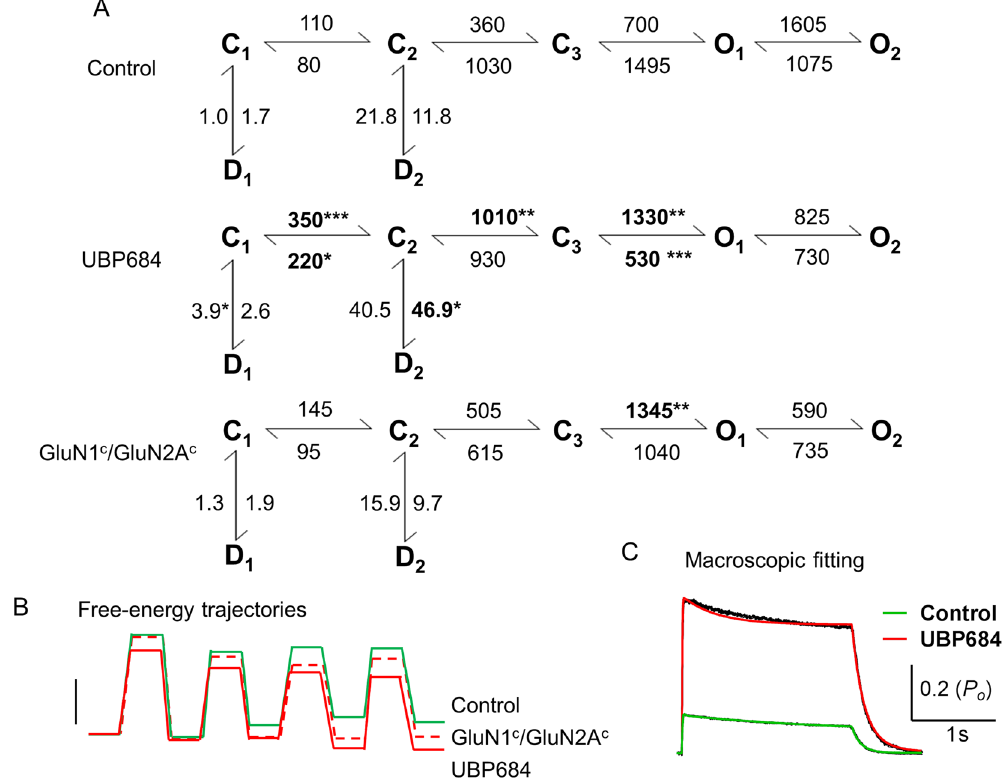
Figure 4. Kinetic mechanism describing the effects of UBP684 on GluN1/GluN2A receptor activation. ( A ) MIL fit of single-channel data to assess the gating mechanism underlying potentiation of UBP684 is shown. All rates are in sec − 1 . Bold numbers with asterisks denote the rates which were significantly different from glutamate/glycine control patches. Rates ± SEM are presented in Table 2. Data was analyzed using unpaired t -test. ( B ) Free-energy trajectories for the kinetic states in the different models are presented. The free energies of the active states for the mutant GluN1c/GluN2Ac is lower than control but is still higher than UBP684. Scale bar represents 1 k B T. ( C ) Macroscopic current profiles were obtained by whole-cell recordings (black traces). Cells were equilibrated to glycine ± UBP684 before exposing to glycine + glutamate ± UBP684 as detailed in Methods. Current profiles were fitted to the kinetic Markov models for control (green) and UBP684 (red) that included glutamate binding and unbinding steps. Except the desensitization rates and the agonist binding and unbinding rates all other rates were fixed to those depicted in the kinetic models. The models were able to accurately predict the activation and deactivation kinetics. Rates obtained from least squares fitting are presented in Table